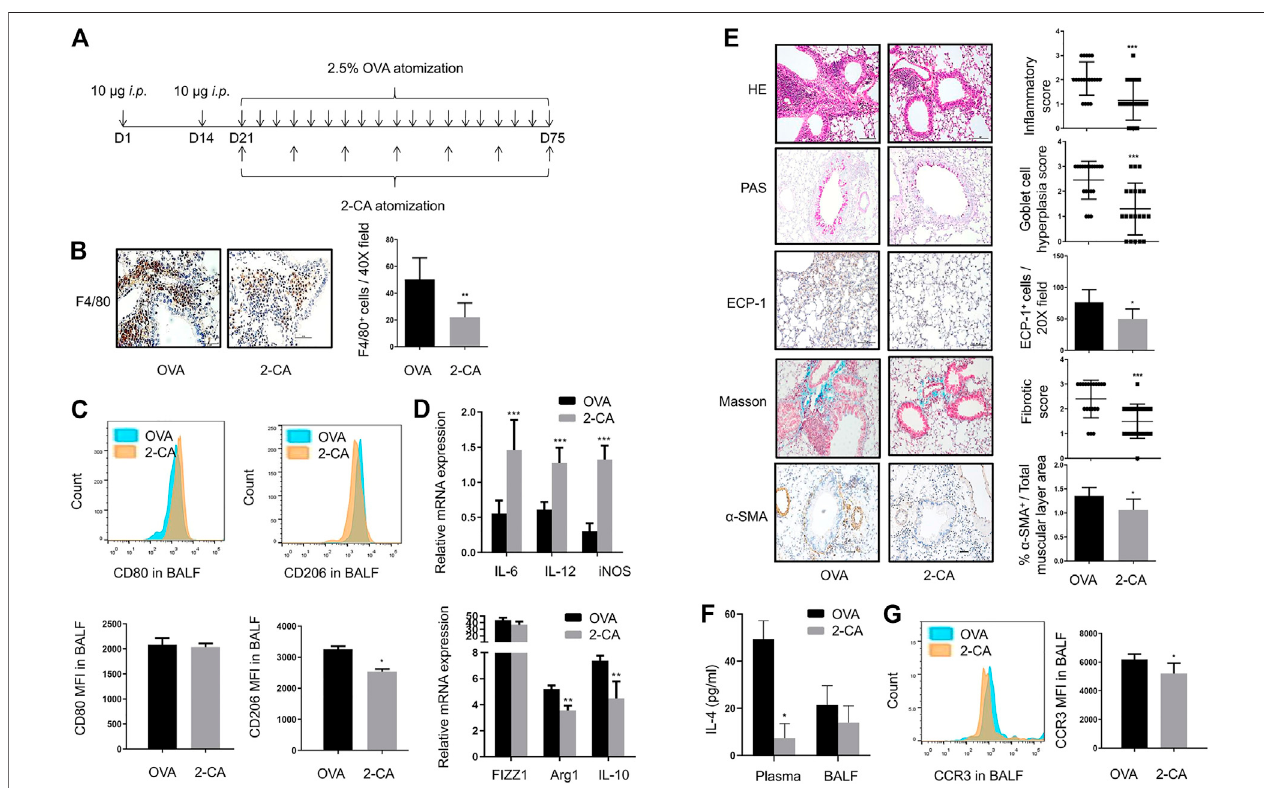
FIGURE 2 | Inhibition of M2 macrophage polarization by 2-CA is accompanied by alleviation of airway in fl ammation and remodeling (A) . Timeline of mice with chronicasthmatreatedwith2-CAbeforeeverysubsequentthreechallengesofOVA (B) .RepresentativeimagesofF4/80immunohistochemistrystainingoflungsections from OVA-sensitized and 2-CA-treated mice as shown at a magni fi cation of 40X. Scale bar: 50 μ m. Quanti fi cation of F4/80 + cells per 40X fi eld (C) . Expression of CD80 and CD206 in alveolar macrophages of BALF from OVA-sensitized and 2-CA-treated mice as determined by fl ow cytometry analysis. The representative histograms and quantitation of the MFI are shown (D) . Expression of IL-6, IL-12, iNOS, FIZZ1, Arg1, and IL-10 in lungs from OVA-sensitized and 2-CA-treated mice evaluated by RT-qPCR (E) . Representative images of HE, PAS, Masson, ECP-1, and α -SMA immunohistochemistry staining of lung sections from OVA-sensitized and 2-CA-treated mice as shown at a magni fi cation of 20X. Scale bar: 50 μ m. Bar graph represent morphometric semi-quantitative analysis of histopathological data from HE, PASand Masson staining. Quanti fi cation of ECP-1 + cells per 20X fi eld and percentage of α -SMA + /total muscular layer area (F) . IL-4 levels in plasma and BALFfrom OVA-sensitized and 2-CA-treated mice assessed by ELISA (G) . Expression of CCR3 in BALF from OVA-sensitized and 2-CA-treated mice as determined by fl ow cytometry analysis. The representative histograms and quantitation of the MFI are shown. ( n (cid:2) 8, * p < 0.05, ** p < 0.01, *** p < 0.001 vs. asthmatic